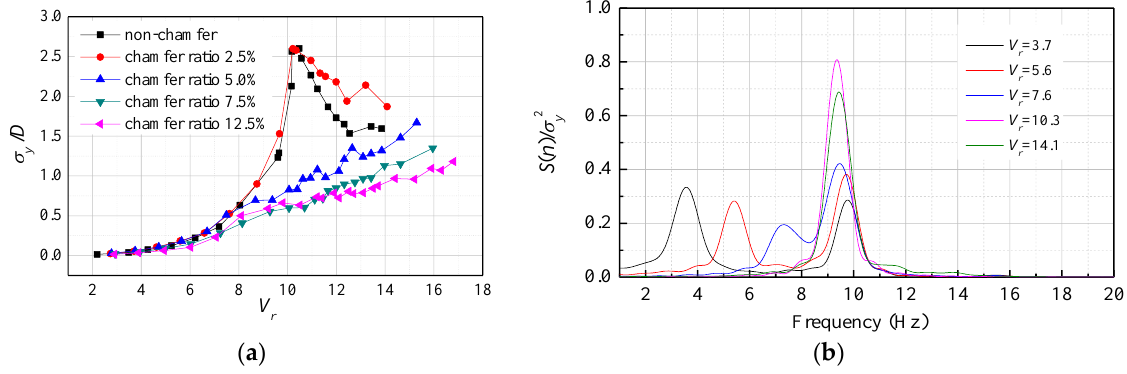
Figure 6. Crosswind responses and the normalized PSD of models with different chamfer ratios: ( a ) RMS responses; ( b ) normalized PSD of crosswind response.